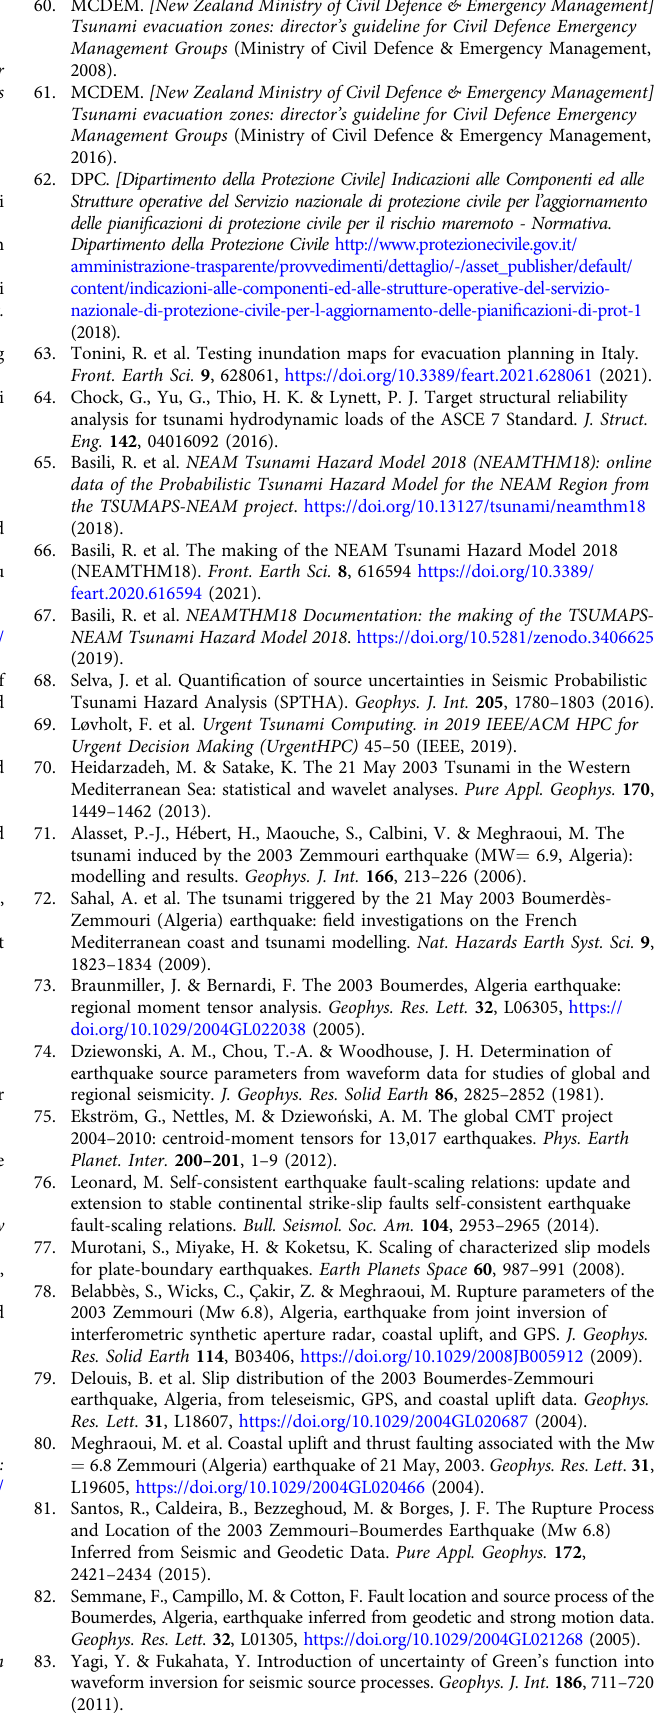
Table 1. Seismol. Res. Lett. 87 , 313 – 322 (2016). 59. Solomos, G., Pinto, A. & Dimova, S. A review of the seismic hazard zonation in national building codes in the context of Eurocode 8 . https://eurocodes.jrc.ec. europa.eu/doc/EUR23563EN.pdf